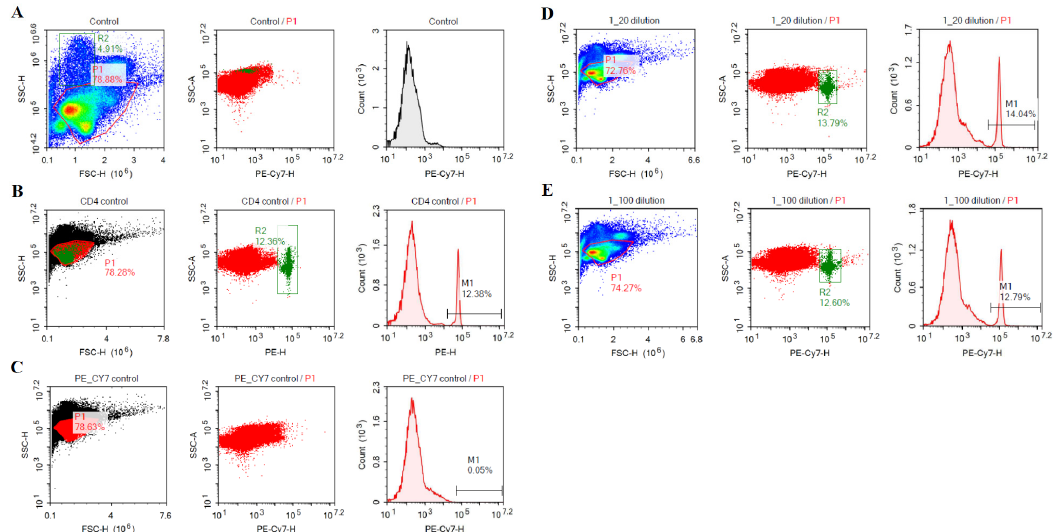
Figure 4. Anti-CD4 mononuclear cell binding specificity. ( A ): Histopaque 1077-treated PBMC (1 × 10 6 cells) with no added antibodies (negative control); ( B ): PBMC stained with mouse anti-chicken CD4-PE antibody (Southern Biotech, positive control); ( C ): PBMC stained with rat anti-mouse IgM-PE/CY7 antibody (secondary antibody only); ( D ): PBMC stained with primary monoclonal antibody isolated from hybridoma cell line (IgM, at 1.5 µ g per 1 × 10 6 cells) and the secondary rat anti-mouse IgM-PE/CY7 antibody; ( E ): PBMC stained with primary monoclonal antibody isolated from hybridoma cell line (IgM, at 0.298 µ g per 1 × 10 6 ) and the secondary rat anti-mouse IgM-PE/CY7 antibody. The gated green cells in the middle of panels ( D , E ) are staining the same population of cells as in the middle of panel B.